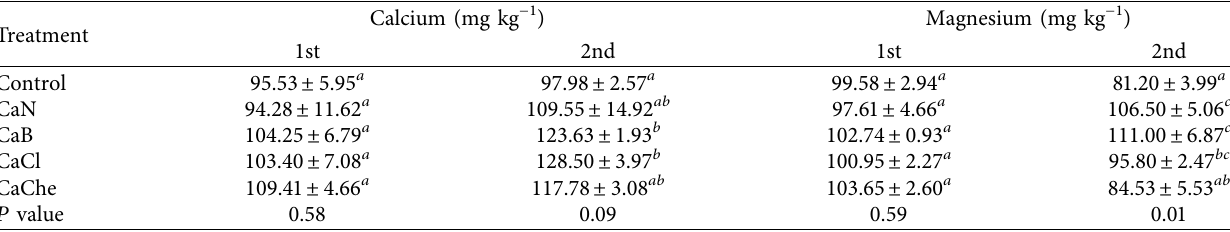
Table 7: Effect of calcium sprays on calcium and magnesium of fruit flesh.